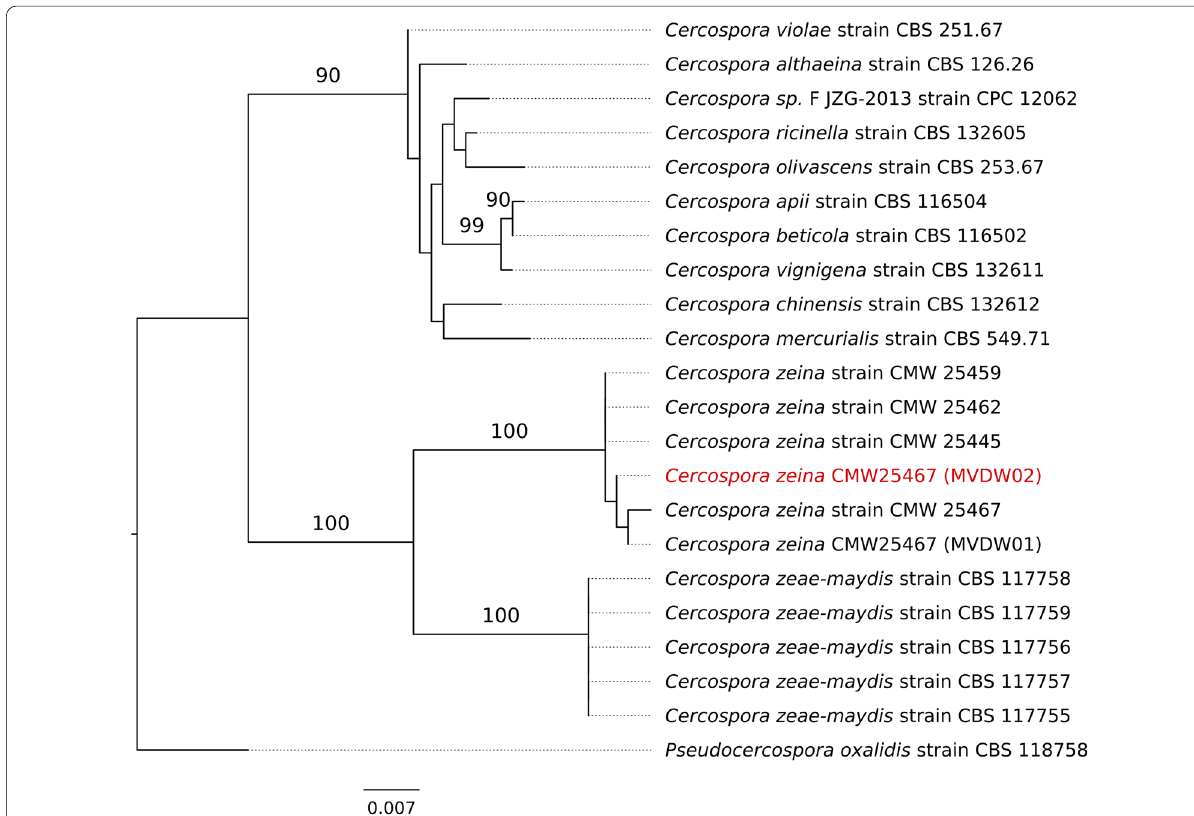
Fig. 4 Phylogenetic tree generated to verify the phylogenetic relationship of the Cercospora zeina isolate sequenced in this study (MVDW02 indicated in red). Maximum likelihood analysis was performed on a concatenated dataset of translation elongation factor 1‑alpha ( TEF1 ) and ITS sequences, with percentage bootstrap (100) values shown. The outgroup was based on Pseudocercospora oxalidis sequences ( TEF1: GU384467.1) and ( ITS : GU269756.1). The branch length represents the mean number of expected substitutions per site. Fungal species and strain names are shown. Accession numbers for sequences can be found in Wingfield et al. 2017, where the previous short‑read assembly (named MVDW01 in